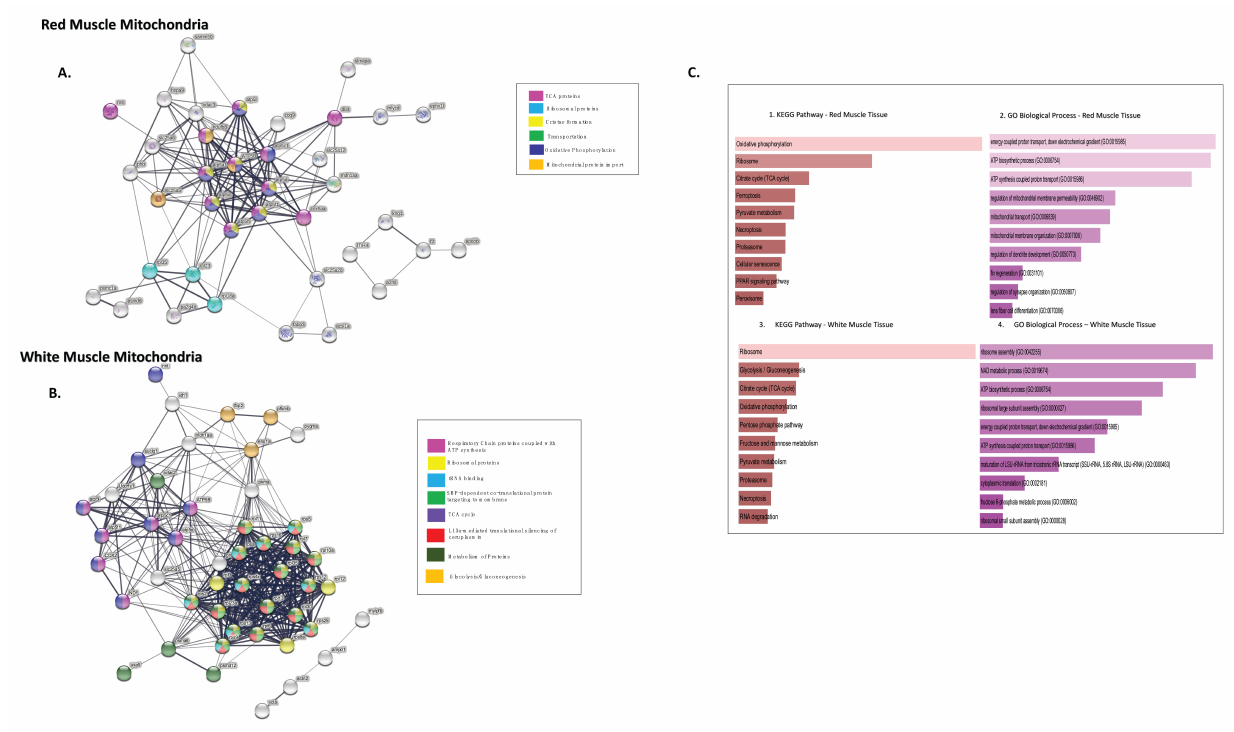
Figure 3. Network analysis of more highly abundant proteins in icefish mitochondria compared with closely related red-blooded species. ( A ) RMM DEPs, number of nodes 42 with 143 edges, the average node degree is 6.8 and ( B ) WMM, number of nodes 56 with 382 edges with an average node degree of 13.6. Network analysed using STRINGdb. The network highlights proteins involved in different pathways curated by STRINGdb from KEGG and Reactome databases. Nodes are coloured according to pathways. The edge shows type of interactions, experimentally determined interactions derived from databases, predicted interactions such as gene neighbourhood, gene co-occurrence, and gene fusions, respectively, co-expression interactions, text-mining interactions, and homology; the thicker the edge, the higher the confidence obtained by the mentioned sources. ( C ) Using FishEnrichr [39,40] analyser KEGG Pathways and GO terms for Biological process showed proteins in different pathways. The length of the bar represents the significance of that specific gene-set or term. Brighter colours are highly